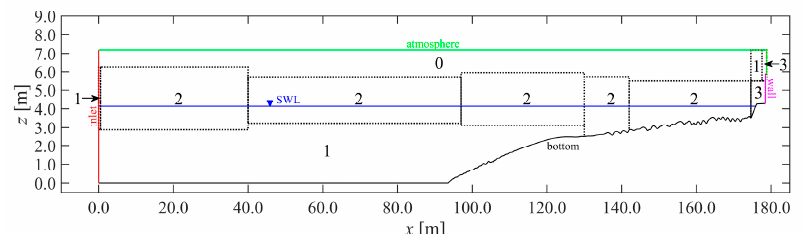
Figure 3. Definition of the OF 2DV computational domain, with coloured indication of the model boundary types. The still water level (SWL) is indicated in blue (z = 4.14 m). The number in each of the mesh subdomains of the model domain (demarcated by black dotted lines) is the refinement level β applied in each subdomain (for β = 0, 1, 2, and 3: ∆ x = ∆ z = 0.18 m, 0.09 m, 0.045 m, and 0.0225 m). Note: the axes are in a distorted scale.